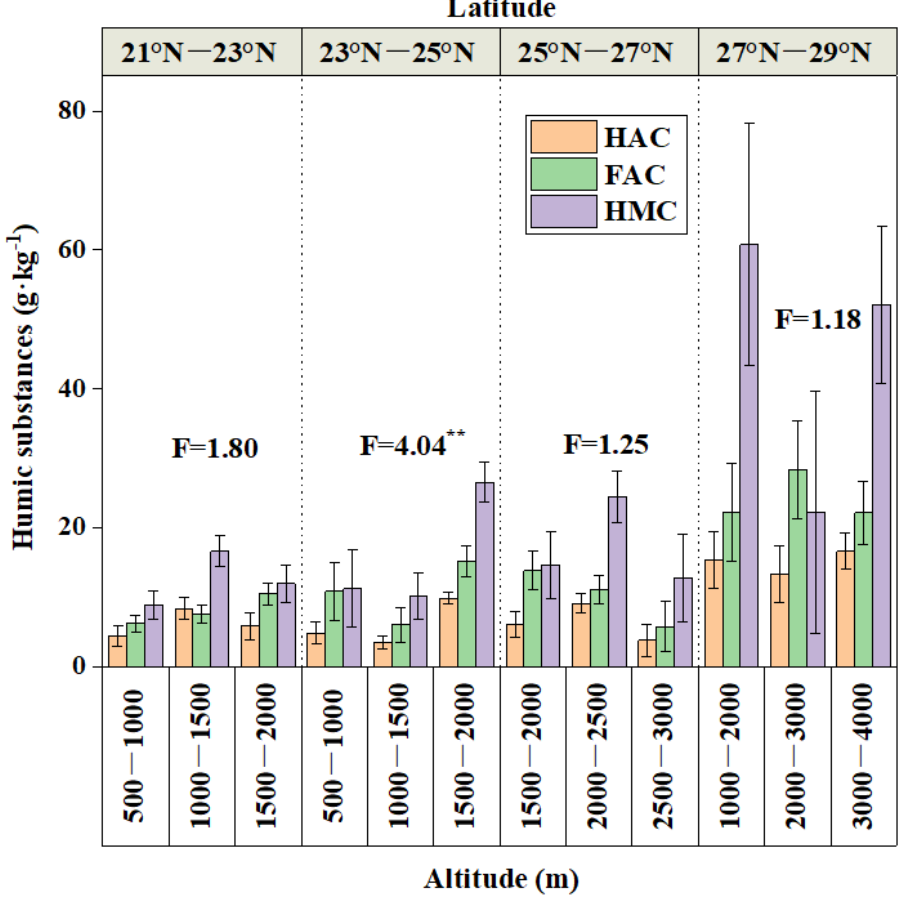
Figure 3. Characteristics of the composition of soil organic matter at different latitudes and elevations. FAC, fulvic acid carbon; HAC, humic acid carbon; HMC, humin carbon. ** p <